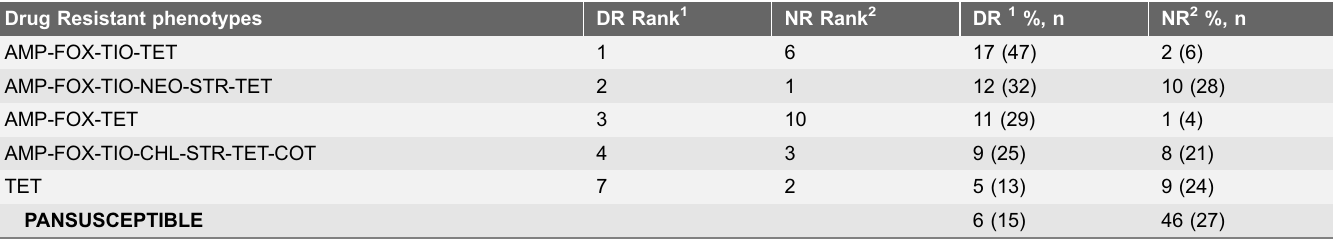
Table 2. Ranking of the most common antimicrobial resistant phenotypes (ARP) among 540 E. coli from fecal samples collected from week 1 to week 6. Drug Resistant phenotypes